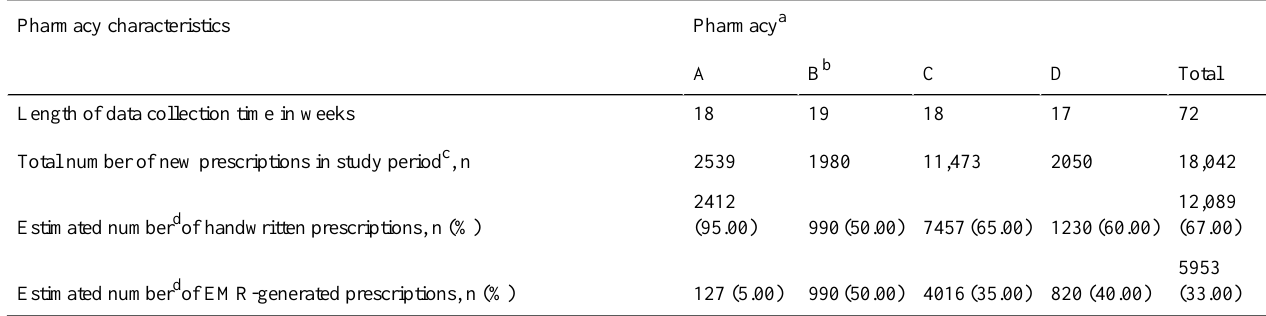
Table 1. Characteristics of study